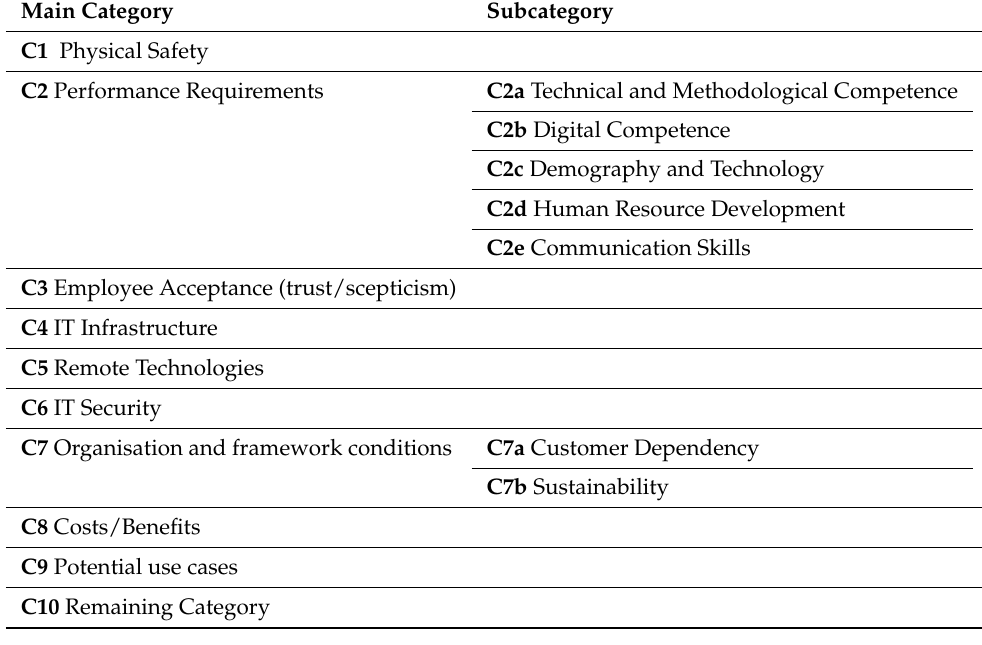
Table 1. Category